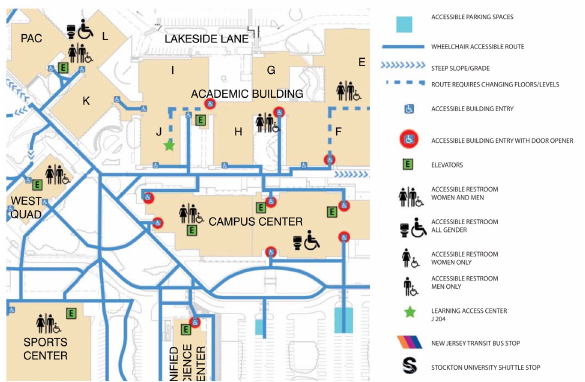
Figure 5. Stockton University (USA) campus accessibility